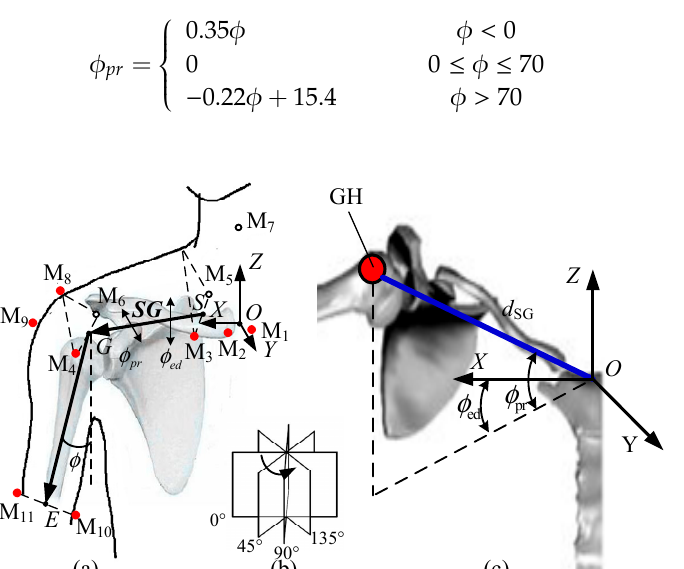
Figure 10. ( a ) Reference points on the shoulder complex and the center of the GH joint in global coordinate frame. ( b ) four anatomical planes. ( c ) calculated position of the GH joint center in the global coordinate system.